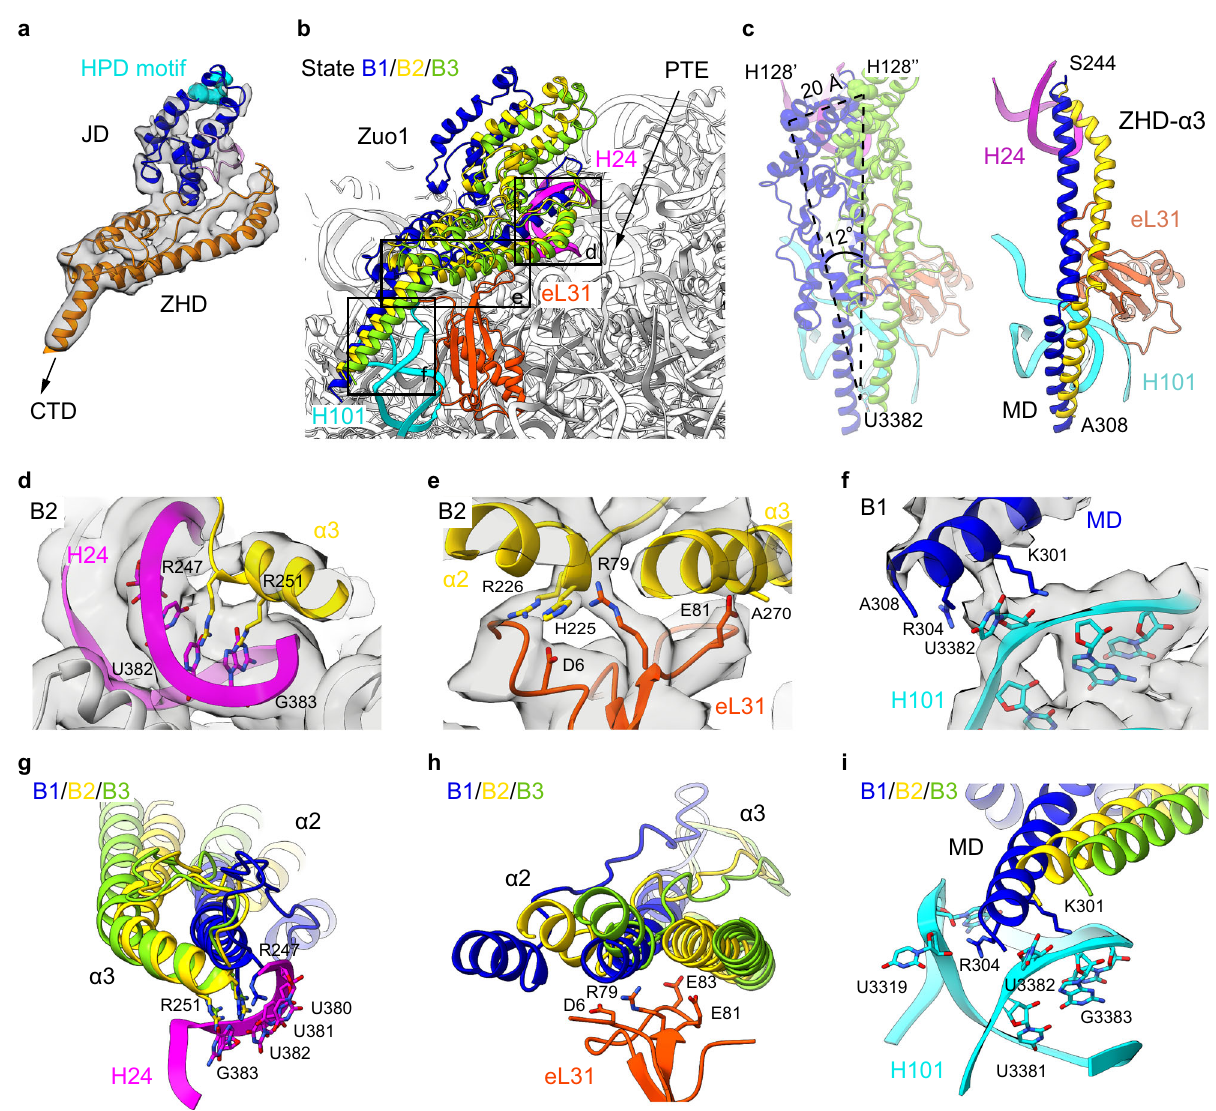
Fig. 2 Dynamic interaction of Zuo1 with the 60S subunit at the peptide exit. a Segmented density map of Zuo1 ZHD and JD (from the RNC-RAC-Ssb1 dataset), superimposed with the atomic model. JD and ZHD are colored blue and orange, respectively. The HPD motif is highlighted in cyan spheres. The density map is from a focused re fi nement (Map 2.4 in Supplementary Fig. 6). b Magni fi ed view of the 60S subunit in the RAC binding region. Zuo1 models of State B1, B2 and B3 are colored blue, gold and green, respectively. H101, eL31 and H24 are colored cyan, orangered and magenta, respectively. c , Comparison of the models of Zuo1 on the 60S subunit. The HPD motif in Zuo1 JD displays up to 12° rotation and 20-Å shift with respect to U3382 of the 25S rRNA (left). The fl exibility of ZHD- α 3 is the structural basis of the dynamics of RAC on the 60S subunit (right). d – f Contact points of Zuo1 with the 60S subunit. Detailed views of interactions between the N-terminus of ZHD α 3 and H24 ( d ) in State B2, between ZHD α 2/ α 3 and eL31 ( e ) in State B2, and between MD and H101 ( f ) in State B1. The atomic models of Zuo1 are superimposed with EM density from State B2 ( d , e ) or State B1 ( f ). Selected residues of Zuo1, eL31 and 25S rRNA are shown in stick models and labelled. The density maps are from Map 2.2 and Map 2.1 in Supplementary Fig. 6. g – i , Structural comparison of the models of Zuo1 (State B1-B3) with respect to the three ribosomal contact points, H24 ( g ), eL31 ( h ) and H101 ( i